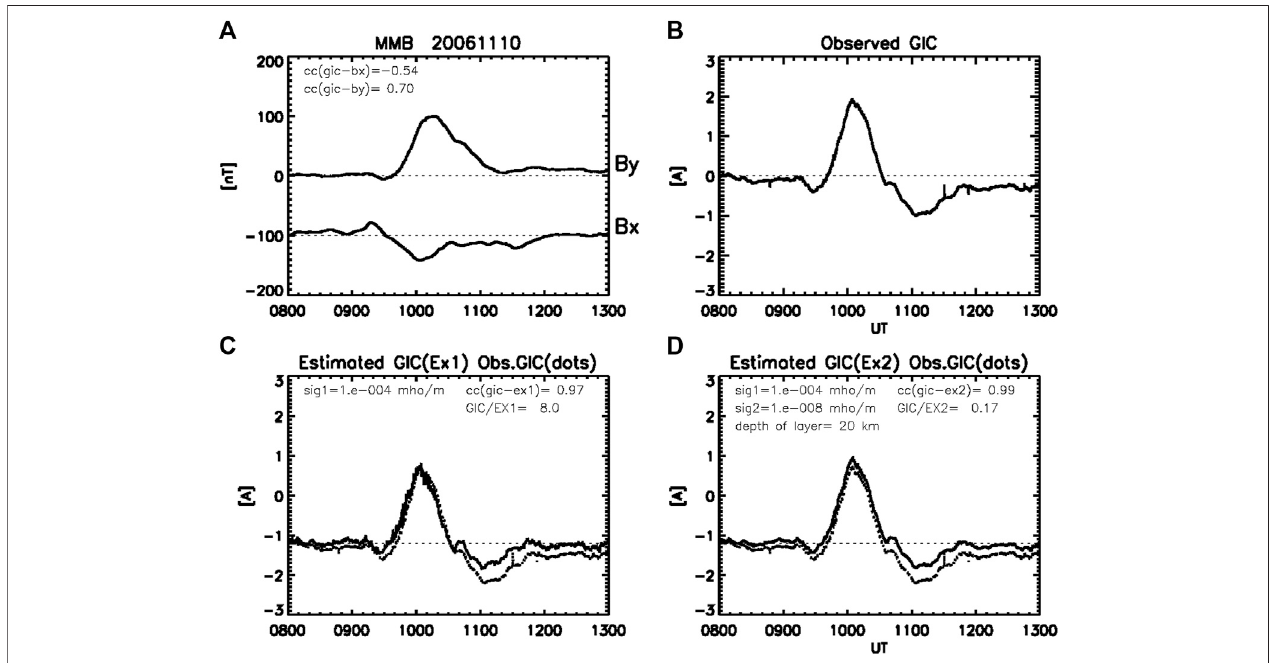
FIGURE 8 | (A, B) B x , B y and GIC observed at MMB in the evening (10 UT, 19 MLT) during the substorm bay event. (C) GIC estimated from E x1 scaled to the GIC with the scale factor, k 1 (cid:1) 8.0 [A/(mV/m)] (solid line) and observed GIC (dotted line). (D) GIC estimated from E x2 scaled to the GIC with the scale factor, k 2 (cid:1) 0.17 [A/(mV/ m)] (solid line) and observed GIC (dotted